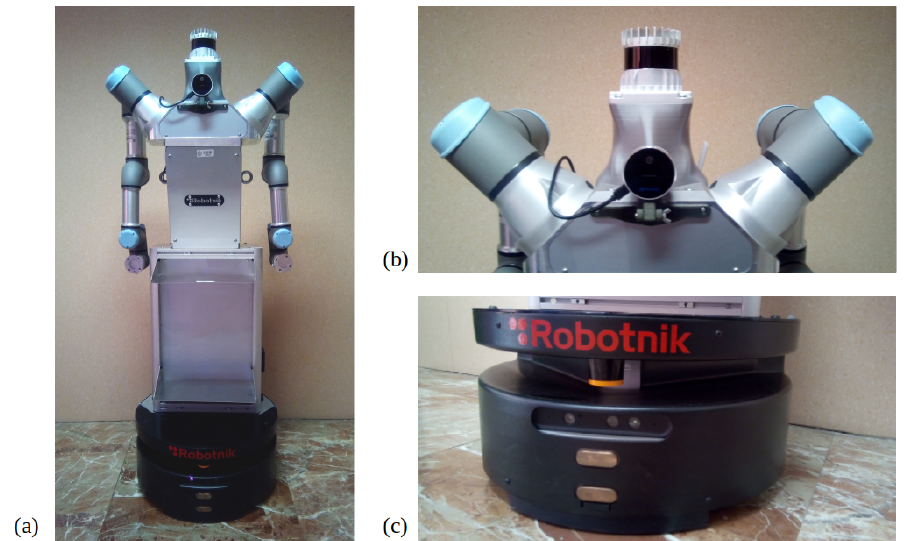
Figure 1. ADAM robot: ( a ) general overview of the mobile robot, where the robotic base, the torso and the two arms can be observed, ( b ) 3D LiDAR and RGBD camera placed at the top of the torso, ( c ) 2D LiDAR placed on the robotic